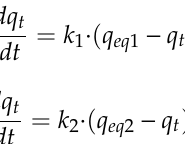
Figure 4. Kinetics of biosorption of Cr(III) ions by biochar produced at different temperatures.